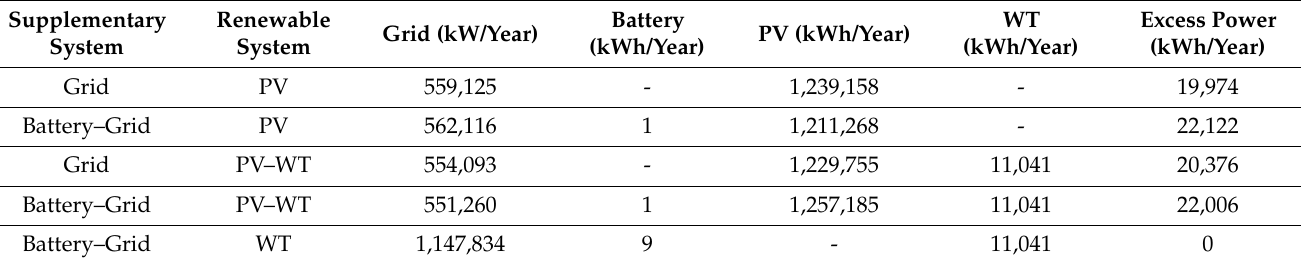
Table 4. Electricity generation with the selected hybrid system configurations for EV charging in a commercial